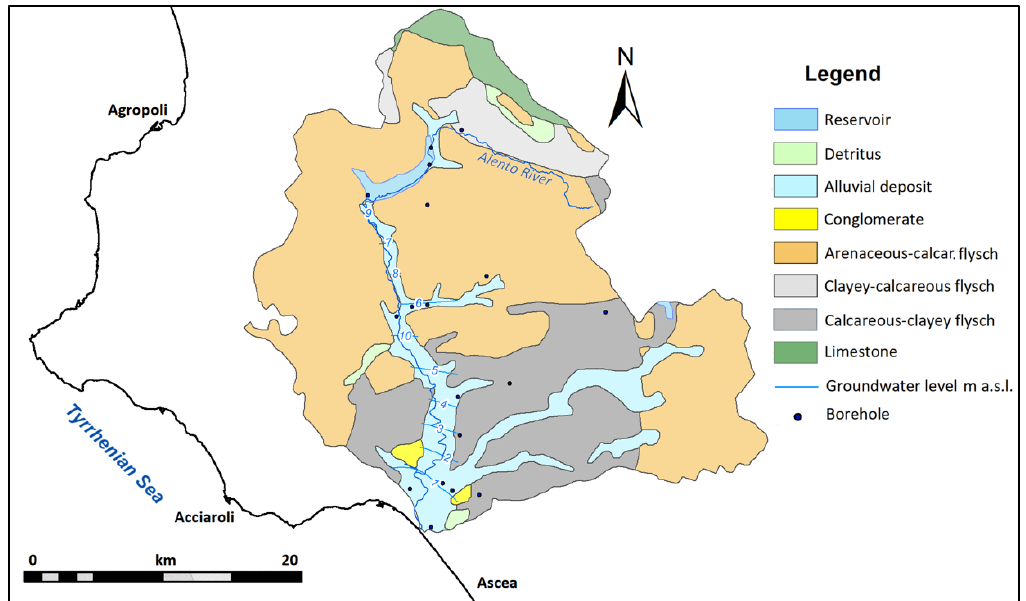
Figure 4. Hydrogeological map of the Alento River basin. Original drawing.